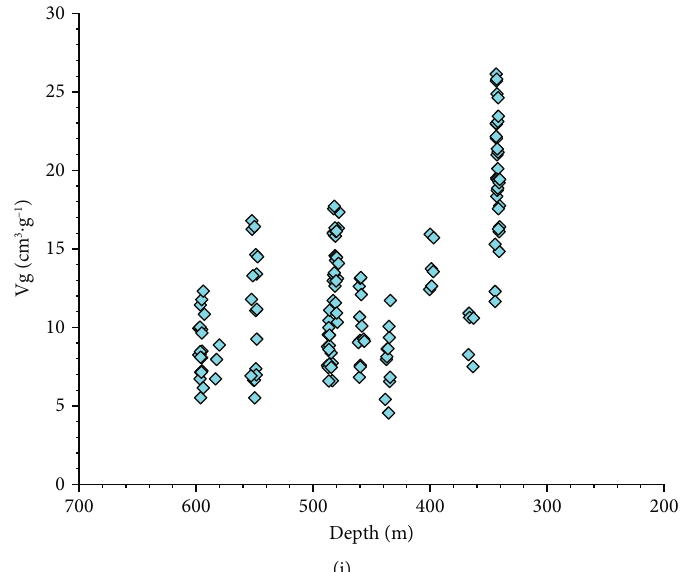
Figure 10: Cross plots of geophysical logging data and Vg: (a) Vg with GR, (b) Vg with SP, (c) Vg with CAL, (d) Vg with DEN, (e) Vg with AC, (f) Vg with CNL, (g) Vg with LLD, (h) Vg with LLS, and (i) Vg with